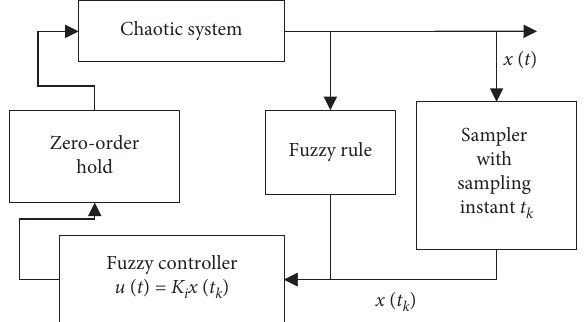
Figure 1: The framework of the sampled-data chaotic